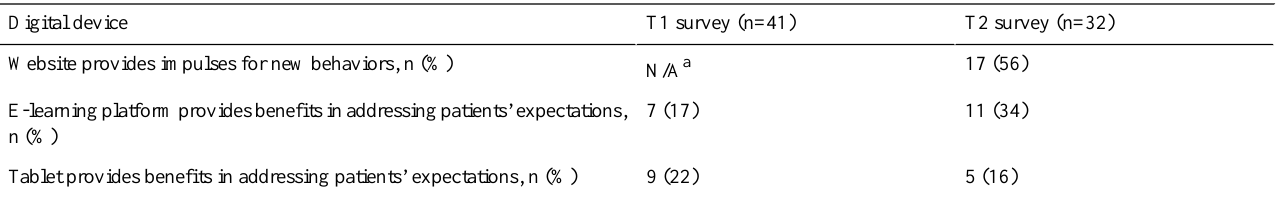
Table 4. Perceptions of the intervention component characteristics by the general practitioners, n